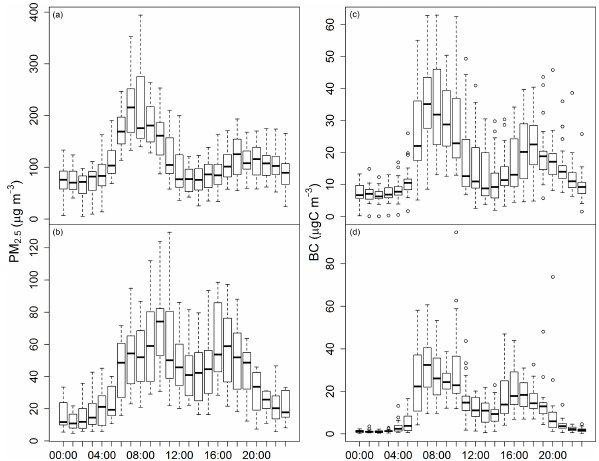
Figure 3. Diurnal variations in PM 2 . 5 and BC concentrations ob- served at six near-road sites in the Kathmandu Valley for entire sam- pling periods in the spring season (a, c) and monsoon season (b, d) . The lower end and upper end of each box represent the 25th and 75th percentiles, respectively; whiskers represent 1.5 × interquar- tile range; the horizontal black line in the middle of each box is the median for each hour of the